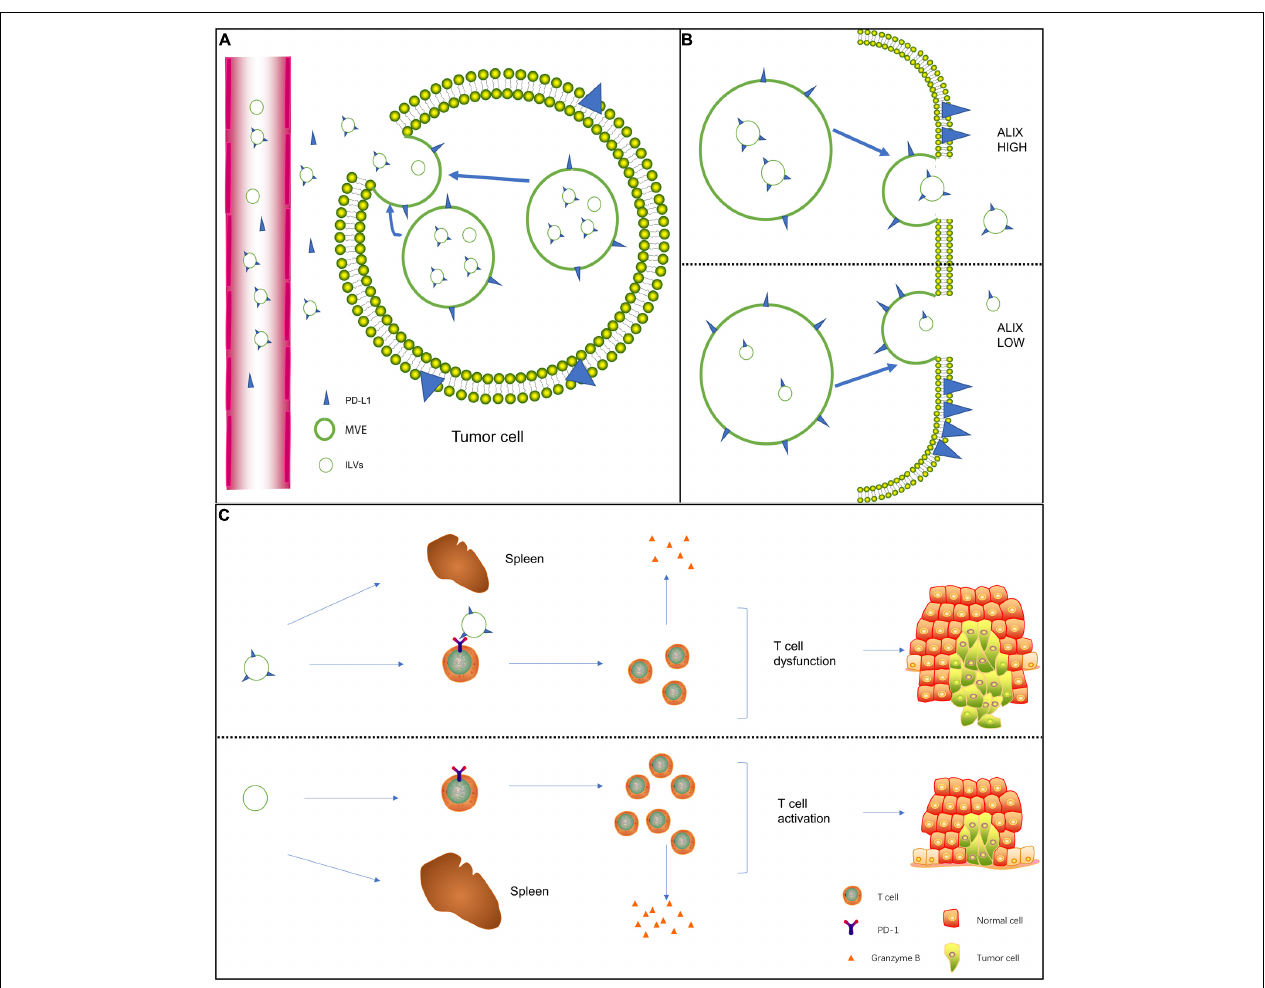
FIGURE 1 | Biogenesis of exosome PD-L1 and its mechanism of action on T cells. (A) In addition to being expressed on the cell surface, free PD-L1 is released from tumor cells to the extracellular space. Free PD-L1 can be divided into exosome PD-L1 and soluble PD-L1. (B) The negative EGFR regulator protein ALIX seems to regulate the assembly of certain exosome cargoes. In ALIX-knockdown cells, PD-L1 expression on the cell surface was strongly increased, but PD-L1 significantly entered exosomes. This decrease indicates that ALIX controls the balance between exosome PD-L1 and cell surface PD-L1. (C) In the presence of exosome PD-L1, the number of activated T cells decreased, the activity of these cells was significantly reduced, the spleen was reduced in size, the level of granzyme B secreted by T cells was significantly reduced, the killing ability of T cells was inhibited, and tumor growth was significantly